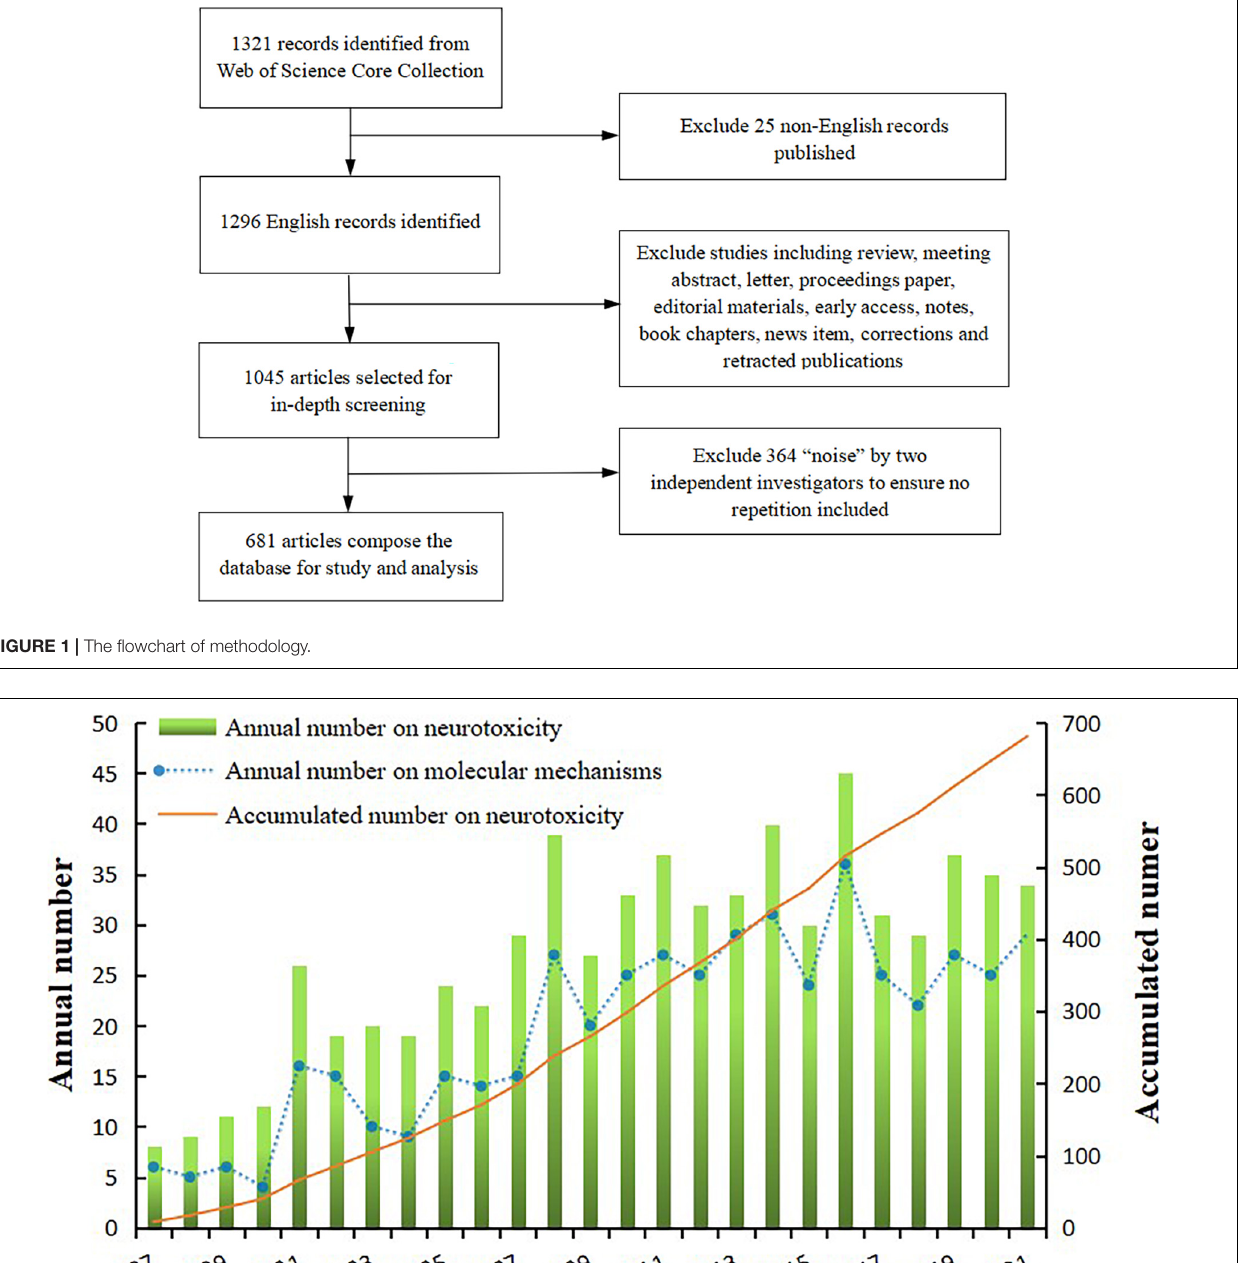
on the WoS was 71; and the top 3 countries were the United States with the highest H-index of 61, followed by Spain (24) and Germany (20). Furthermore, the core institutions in the countries, such as Portugal (90.00%), South Korea (38.89%), and Iran (33.33%), had other national achievements ( Table 1